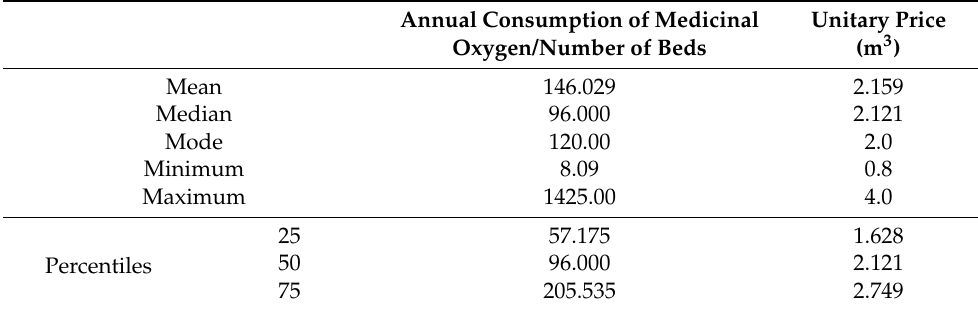
Table 3. Descriptive statistics for annual consumption of medicinal oxygen and unitary